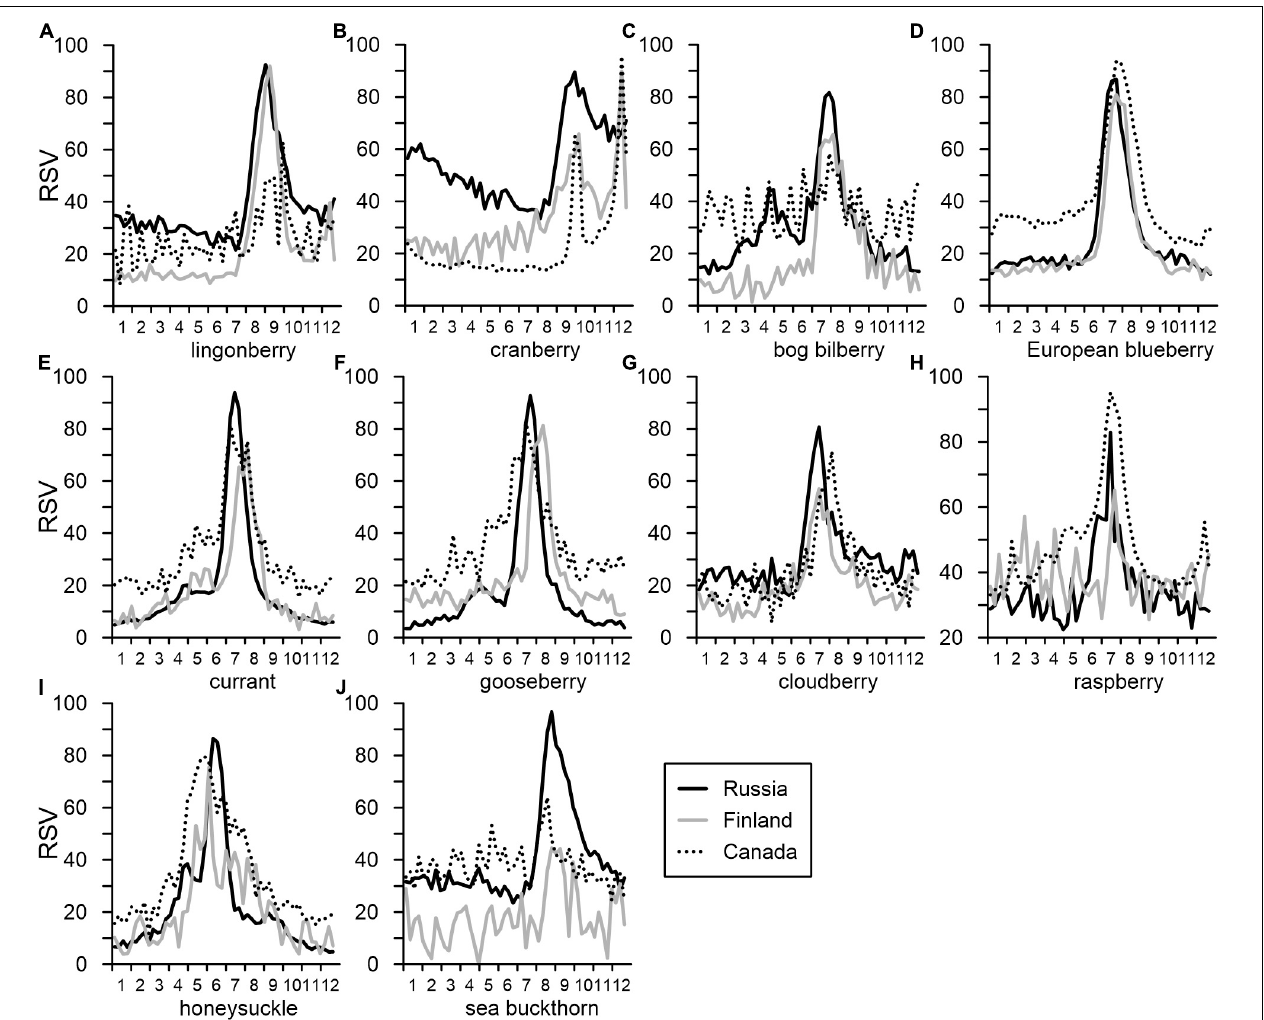
FIGURE 6 | Weekly relative search volume (RSV) 10-year mean of (A) lingonberry, (B) cranberry, (C) bog bilberry, (D) European blueberry, (E) currant, (F) gooseberry, (G) cloudberry, (H) raspberry, (I) honeysuckle, and (J) sea buckthorn for Russia, Finland, and Canada. In the case of Canada, (C) bilberry and (D) blueberry were